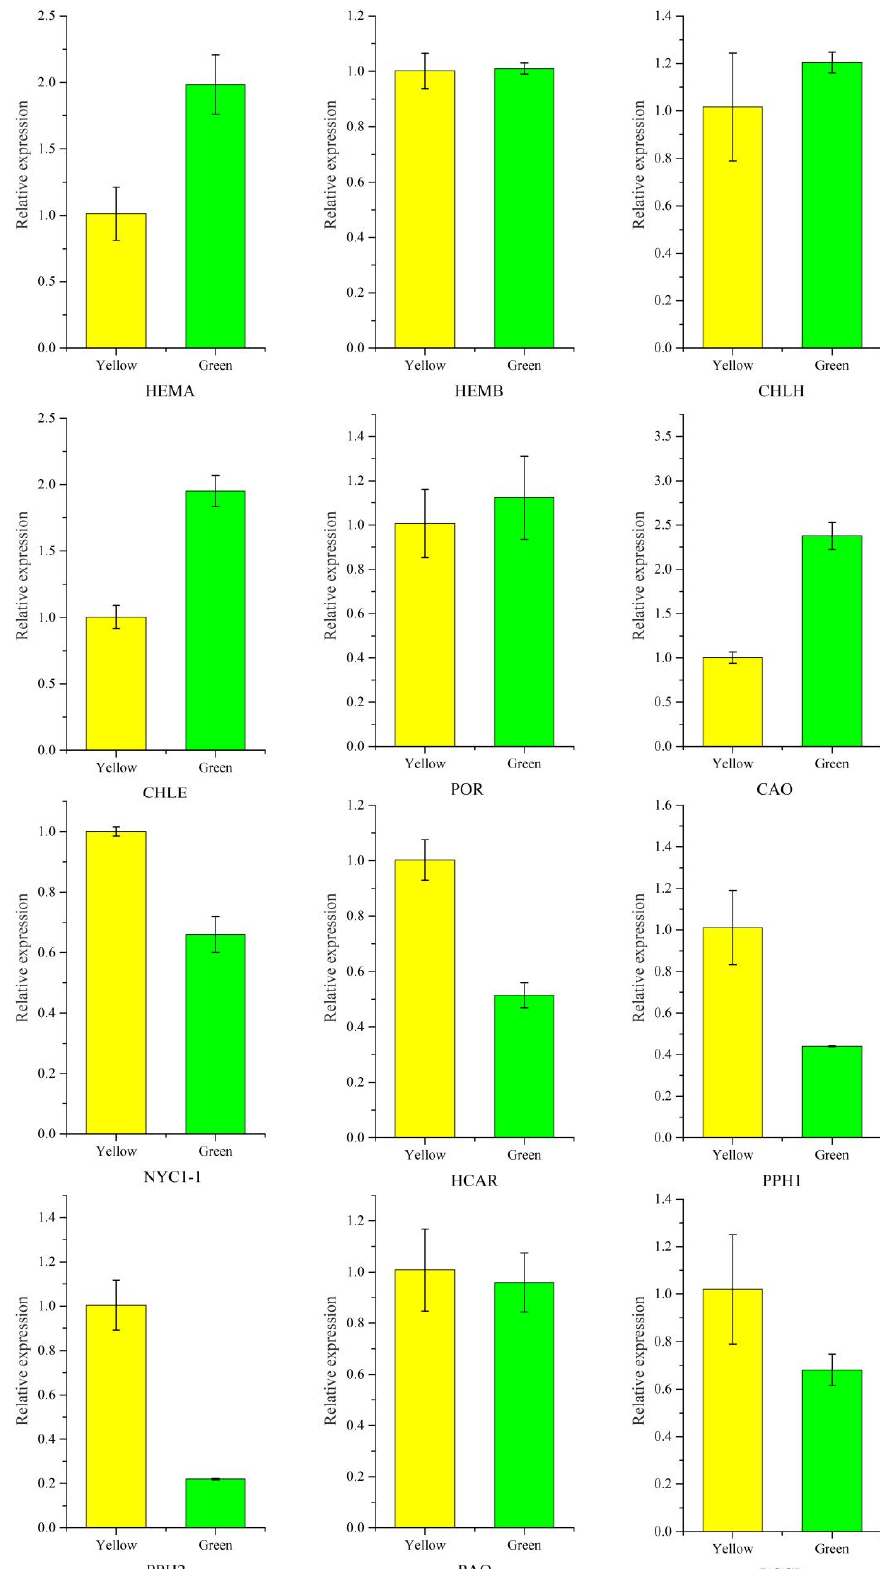
Figure 9. Validation of chlorophyll-related gene expression between P. SCBG COP15 and the yellow mutant. Expression levels were calculated by the 2 −ΔΔ CT method with the actin gene (TRIN- ITY_DN13664_c0_g3) as the internal control.